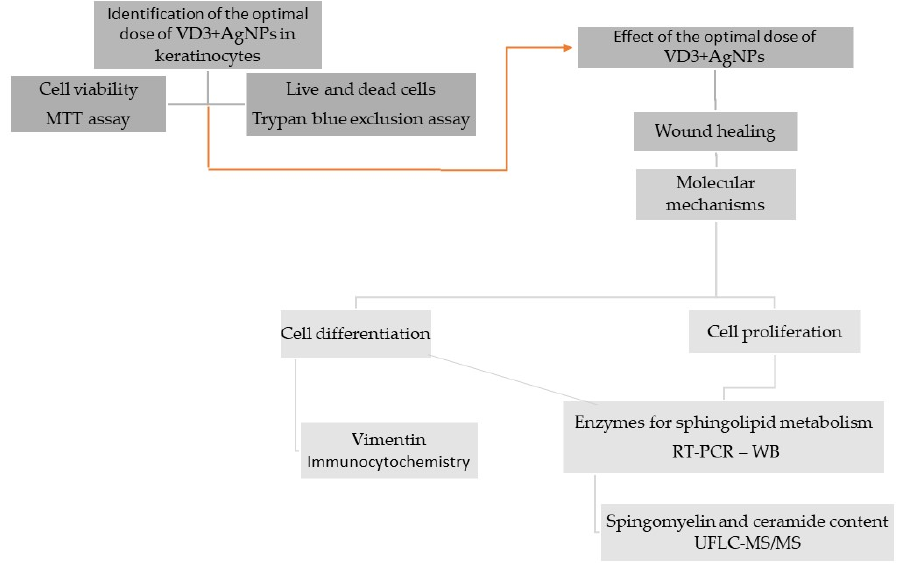
Figure 6. The experimental plan first envisaged the identification of the optimal dose of the VD3 ‐ AgNPs combination that did not induce cytotoxicity. Once the optimal dose was chosen, this was used to test its effectiveness on wound repair in vitro. Then, it was planned to study the molecular mechanisms on the differentiation and proliferation of keratinocytes, paying particular attention to the metabolism of sphingolipids.